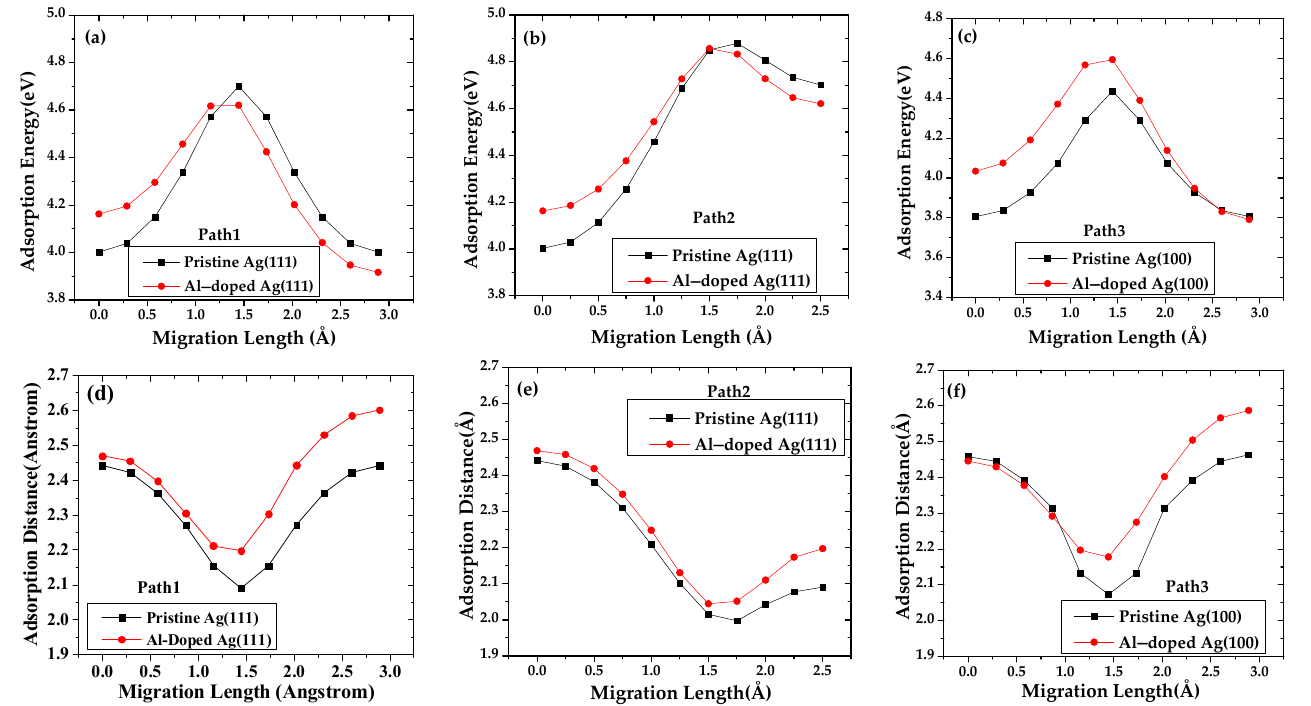
Figure 8. Adsorption energy of aluminum adatom migration pristine Ag (111)/Ag (100) surface and Al-doped Ag (111)/Ag (100) surface along ( a ) path 1, ( b ) path 2 and ( c ) path 3, and corresponding adsorption distances of aluminum adatom migration are represented by ( d ) path 1, ( e ) path 2 and ( f ) path 3.